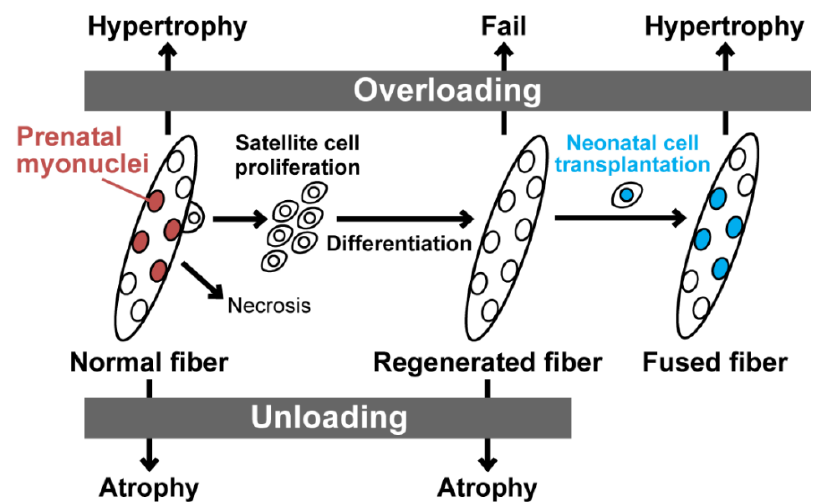
Figure 5. Hypertrophic function programmed by prenatal myonuclei. Myonuclei that are incorporated into muscle fibers during the development (prenatal myonuclei) persist in the adult muscle fibers. Muscle injury leads to a loss of the prenatal myonuclei. Although muscle fibers are regenerated via satellite cell proliferation and differentiation, the regenerated fibers fail to undergo hypertrophy in response to overloading. See the main text and Kawano et al. [51] for more details.